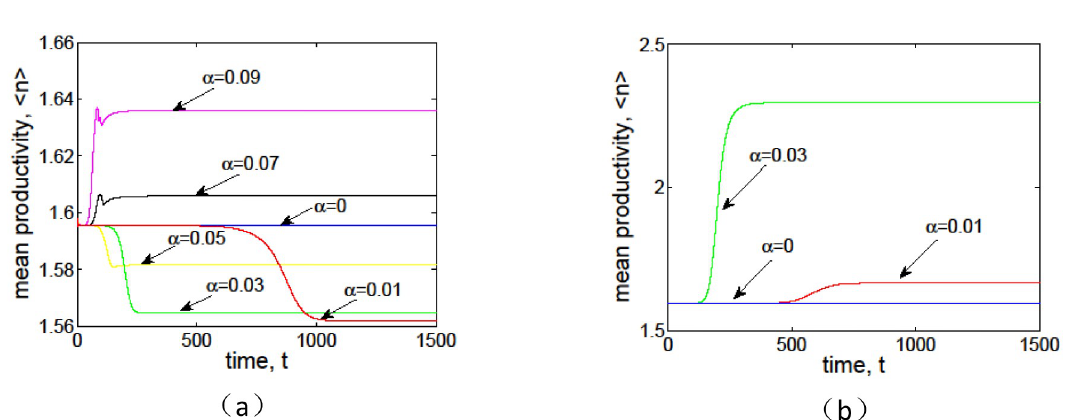
Fig 11. Effects of infiltration positive feedback coefficient α on mean productivity of vegetation pattern in arid area. The fixed parameter values (a) p = 1, δ = 0.45, v = 9, which corresponds to grass; (b) p = 0.1, δ = 0.045, v = 30, which corresponds to tree.